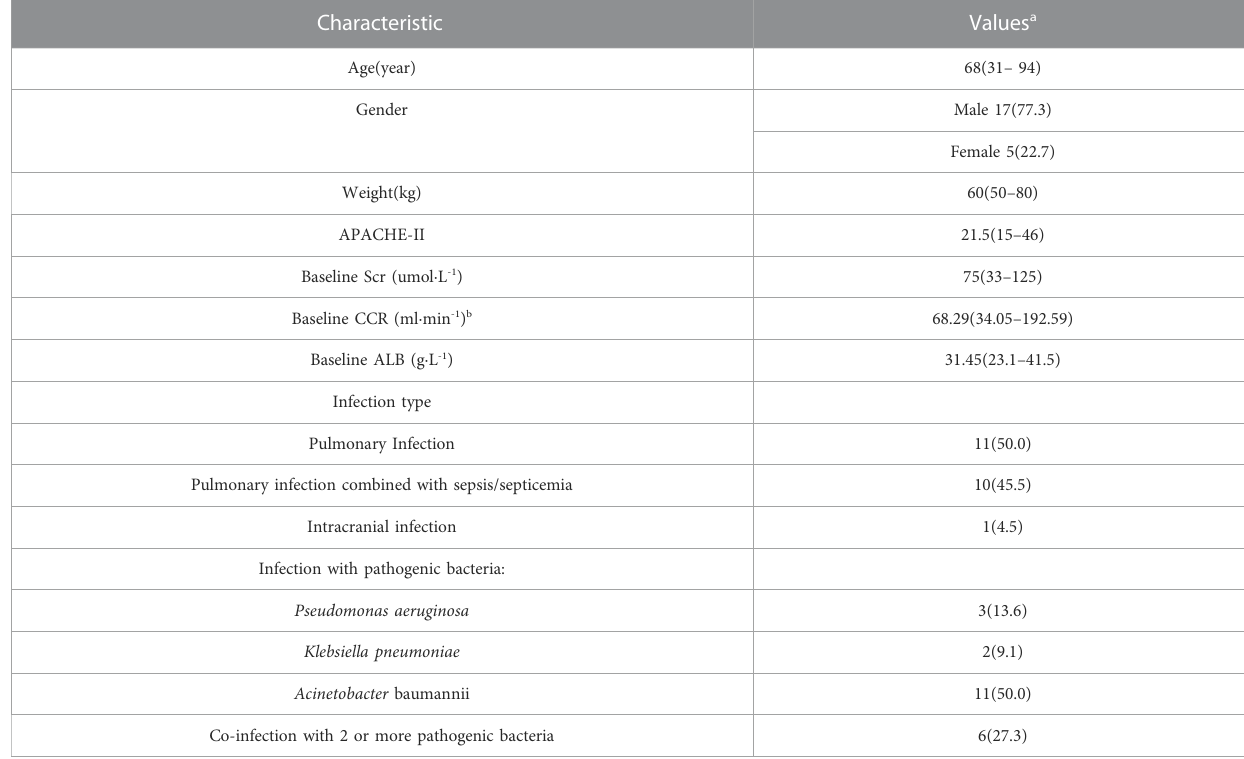
TABLE 1 Characteristics of patients treated with polymyxin B.